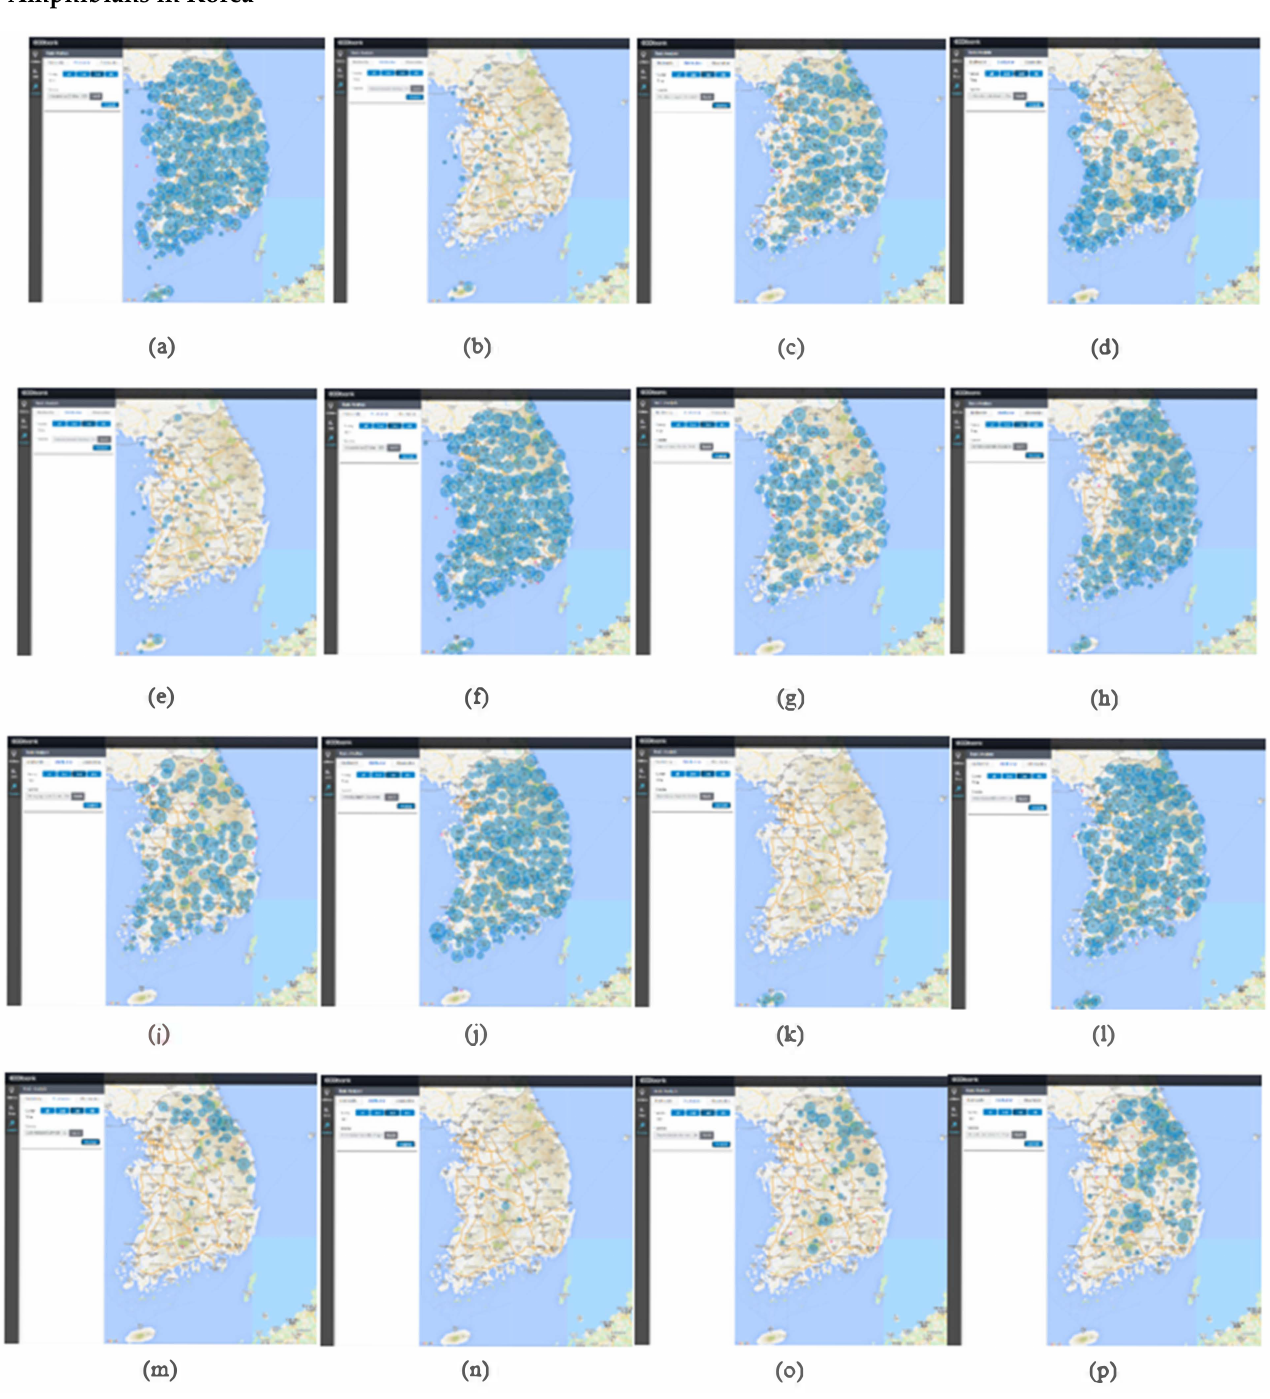
Figure A1. ( a ) H. japonica ; ( b ) K. borealis ; ( c ) G. rugosa ; ( d ) L. catesbeianus ; ( e ) P. chosenicus ; ( f ) P. nigromaculatus ; ( g ) R. coreana ; ( h ) B. orientalis ; ( i ) B. gargarizans ; ( j ) H. leechii ; ( k ) H. qualpartensis ; ( l ) R. dyboskii ; ( m ) B. stejnegeri ; ( n ) K. koreana ; ( o ) O. koreanus ; ( p ) R. huanrenensis